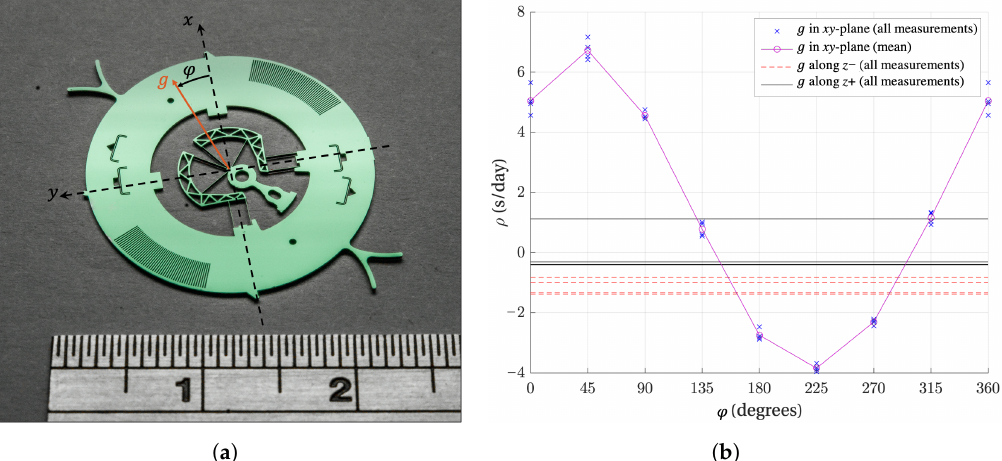
Figure 2. Watch-scale silicon co-RCC oscillator ( a ) and its experimental daily rate ρ ( b ) for varying angle ϕ of the gravity load in the xy-plane (oscillation plane) and for gravity acting along the z axis (rotation axis). Four measurements were performed in each position [4].